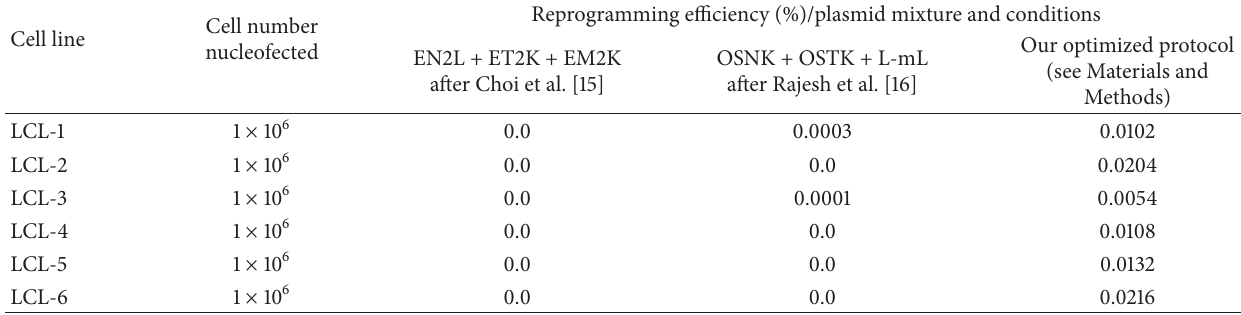
Table 1: iPSC induction efficiency from six LCL